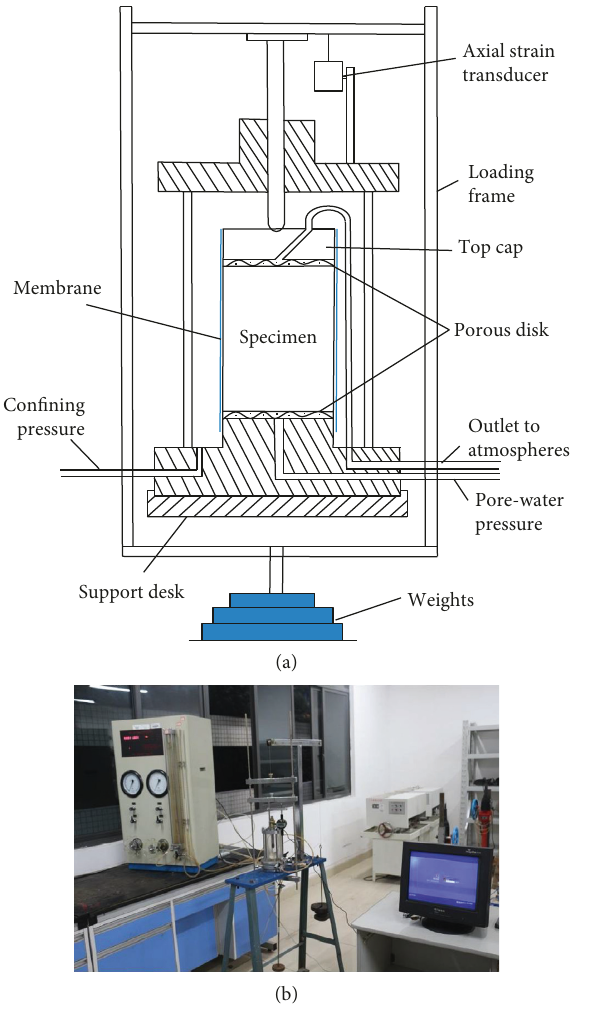
Figure 1: The weight-controlled stress loading system. (a) A schematic diagram. (b) Real picture of the apparatus. Table 2: Experimental deviatoric stress levels at different confining pressures (unit: kPa).